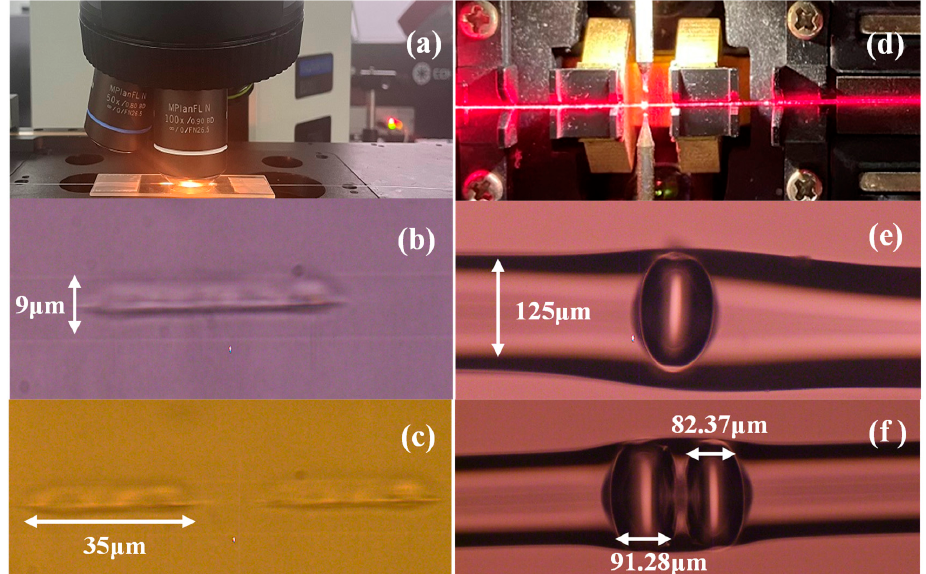
Figure 1. ( a ) Fabrication system for femtosecond laser scribing; ( b ) a horizontal short-line structure inscribed in fiber core; ( c ) two horizontal short-line structures inscribed in fiber core; ( d ) discharge the short-line area; ( e , f ) one or two bubbles are formed.